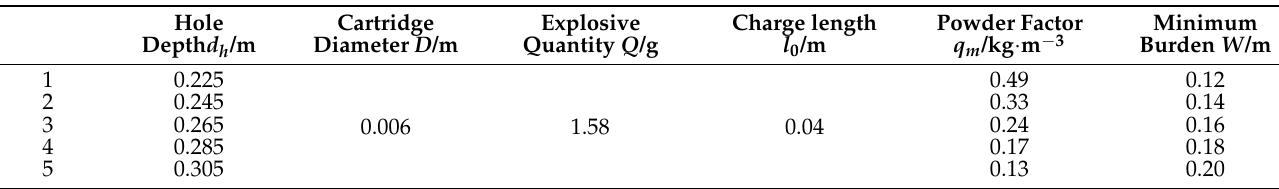
Table 4. Parameters of